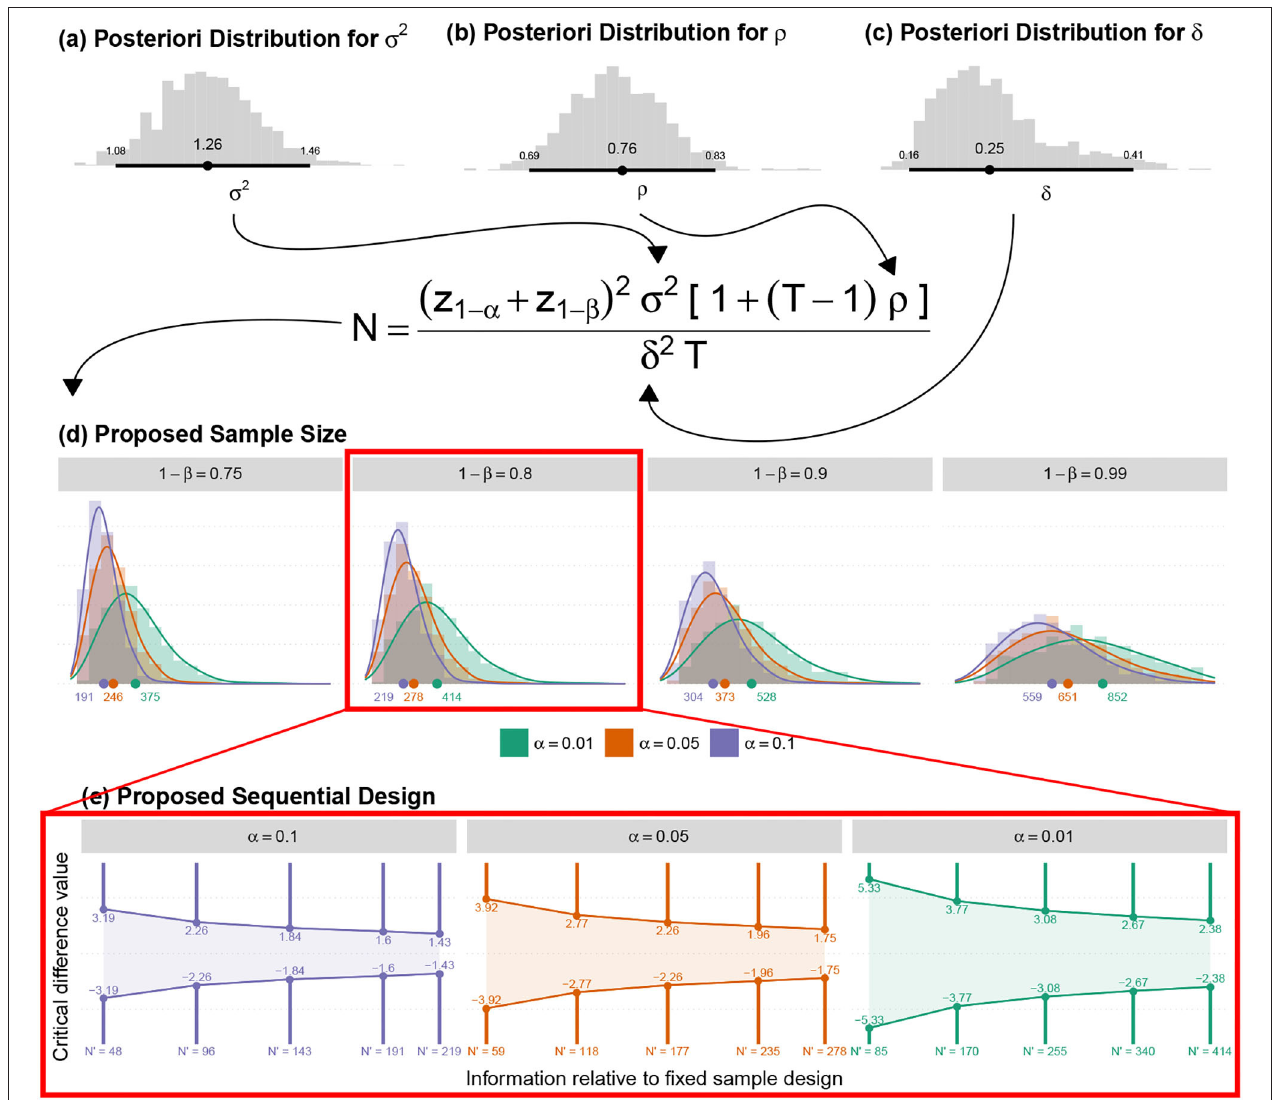
FIGURE 12 | (a) The posteriori distribution for the marginal variance of the adjusted model; (b) The posteriori distribution of the correlations, obtained by the average correlations between all-time points. (c) The posteriori distribution of the Minimum Clinical Efficacy was obtained with the adjusted model. (d) The posteriori distribution of the new sample sizes (for all other fixed amounts). (e) The suggested sequential sampling